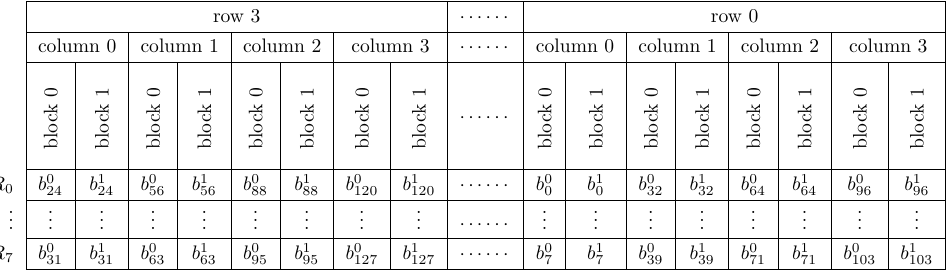
Figure 4: Bitsliced representation from [SS16] using 8 32-bit registers R 0 , · · · , R 7 to process 2 blocks b 0 , b 1 in parallel where b i refers to the j -th bit of the i -th block. j The advantage of this representation is the ability to compute the MixColumns operation using only 27 exclusive-ORs and 16 rotations. Indeed, because each byte in the internal state is an element of GF(2) /x 8 + x 4 + x 3 + x + 1, multiplication by 2 is achieved by a